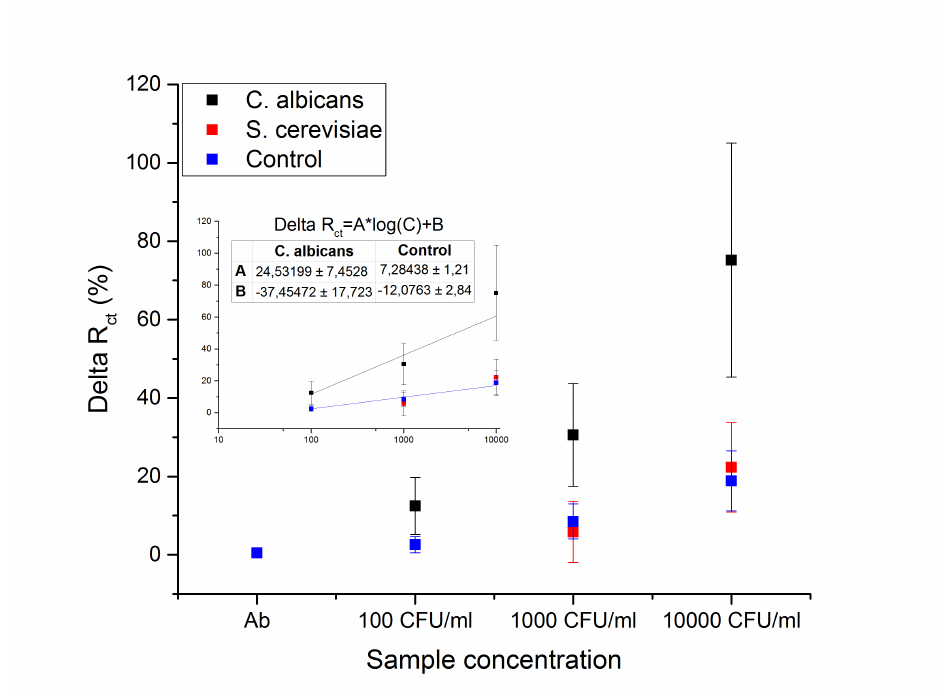
Figure 5. The specificity of the sensor is shown in the graph of normalized charge transfer resistance ( DeltaR ct ) for S. cerevisiae and C. albicans on the sensor surface with or without antibodies. The data from 3 experiments are normalized and averaged. Only binding of C. albicans evoked a significant change in charge transfer resistance, whereas control and S. cerevisiae binding resulted in only small change in R ct . The linear fit of the data is shown in the graph insert together with the equation of the calibration curve for C. albicans and